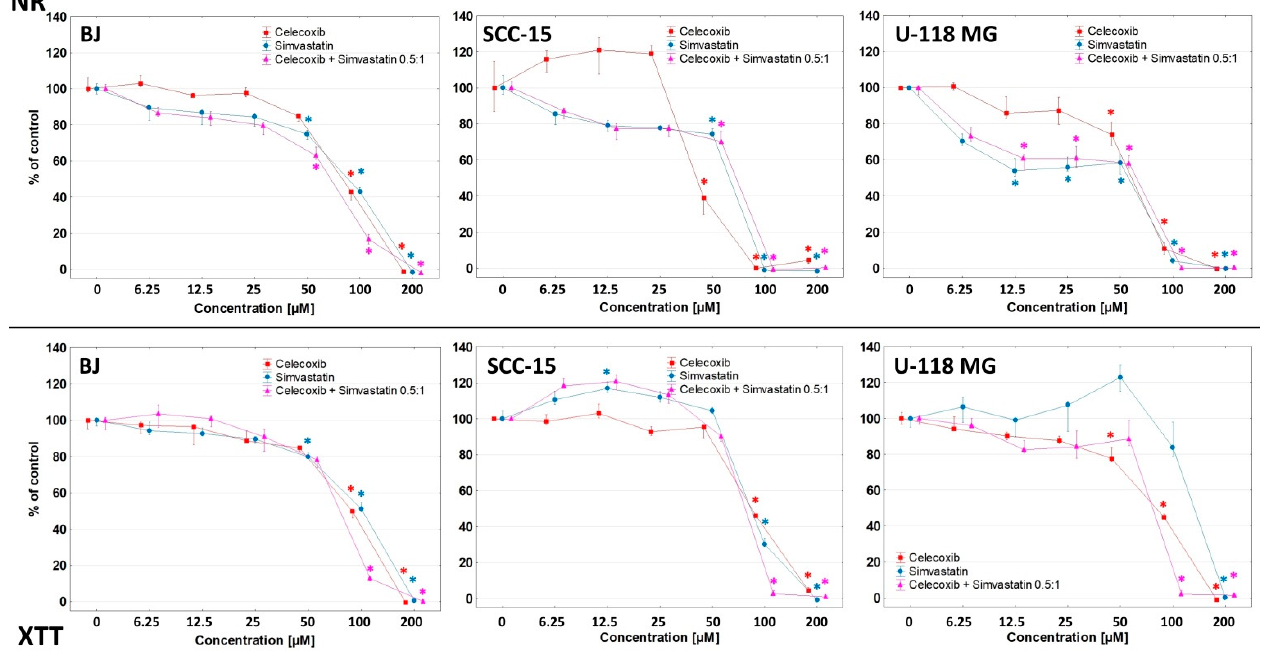
Figure 2. Effect of single drugs celecoxib, simvastatin, and 0.5:1 mixture of celecoxib and simvastatin on normal BJ and cancer SCC-15 and U-118 MG cell viability, estimated with NR and XTT assays after 24 h incubation. Cell viability is presented as medians of a percent against non-treated control (control expressed as 100%). The whiskers are lower (25%) and upper (75%) quartile ranges. * p ≤ 0.05; Kruskal–Wallis test (against non-treated control).